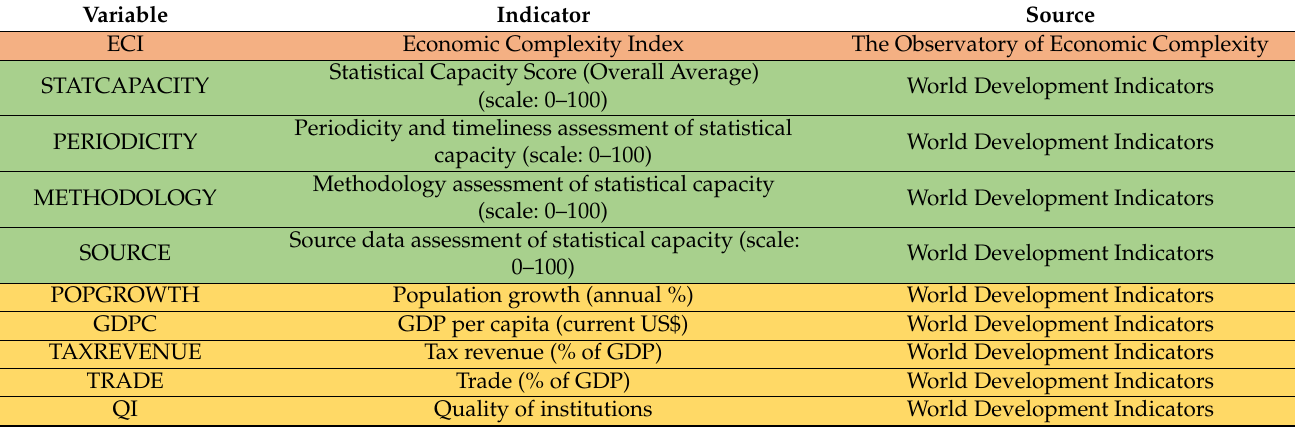
Table 1. List of